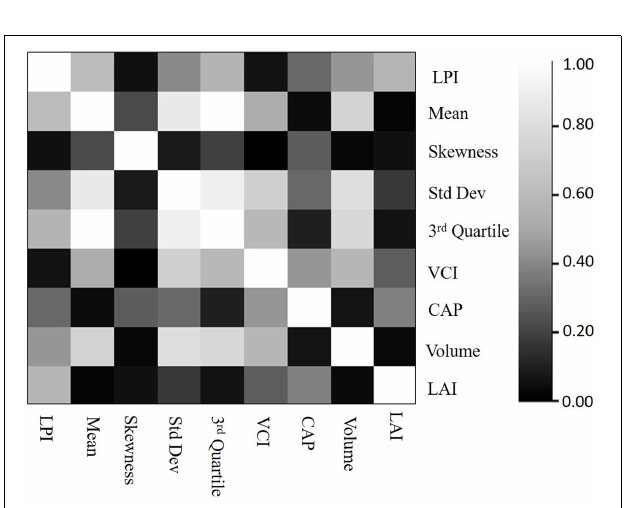
where HB = total number of height bins, p i =